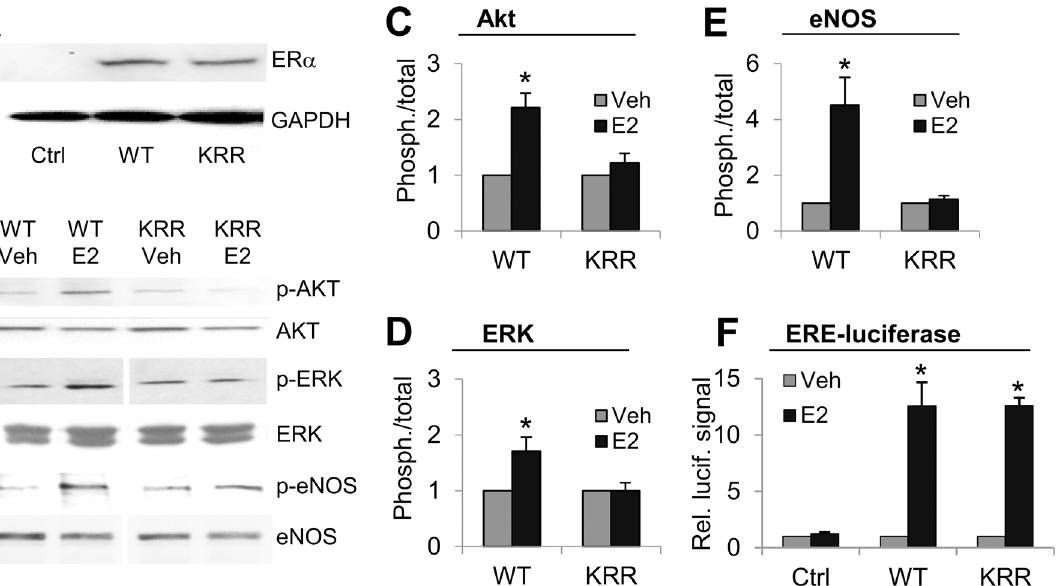
Fig 3. KRR mutant ER α in stable EC cell lines activates genomic but not rapid signaling. (A) Western blot for ER α or GAPDH (as an internal control) in Ctrl, WT or KRR stable Eahy926 cell lines. All WT or KRR clones had similar levels of ER α expression, while all Ctrl hEC clones had no detectable ER α expression (DNS). (B-E) WT or KRR hECs were treated +E2 or +Veh for 20 mins, followed by Western blotting for total versus phosphorylated active forms of endogenous Akt (C) , ERK (D) or eNOS (E) , as per Fig 2A – 2D, with representative images in (B) . (F) WT or KRR hECs were transfected with ERE-luc & β -gal reporter plasmids, as per Fig 2E. * : p. < 0.05. All WT or KRR clones had similar levels of ERE-binding genomic ER α function, measured as E2-induced luciferase expression in this assay, while all Ctrl hEC clones had no significant E2-induced luciferase activity